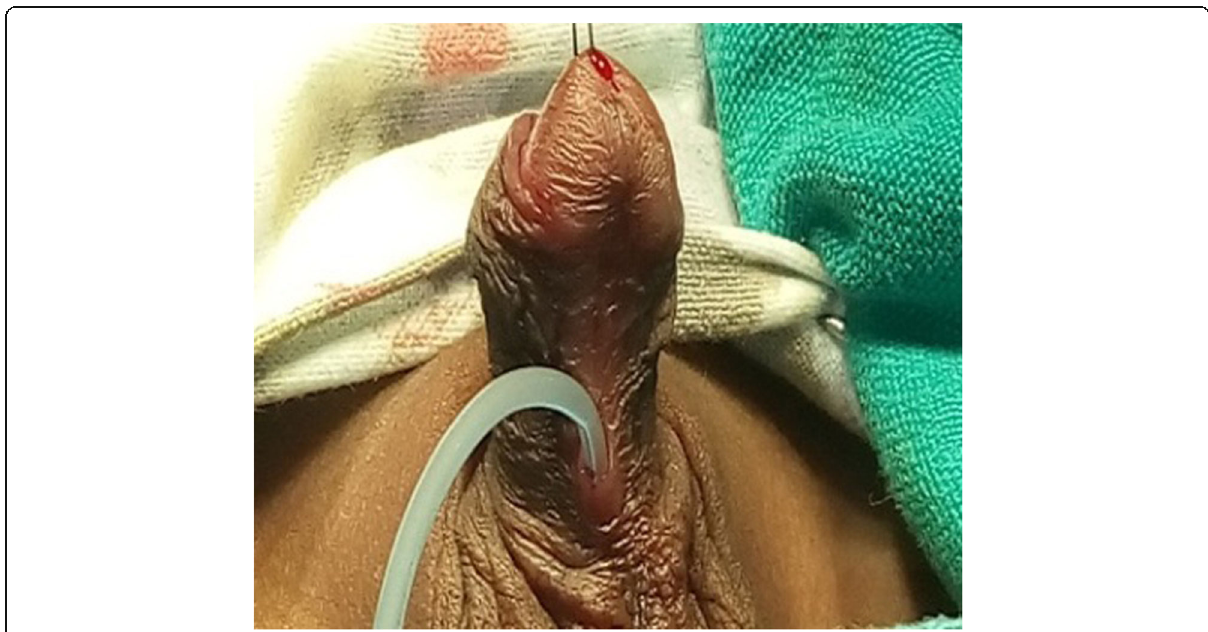
Fig. 2 Preoperative picture of proximal hypospadias with ventral